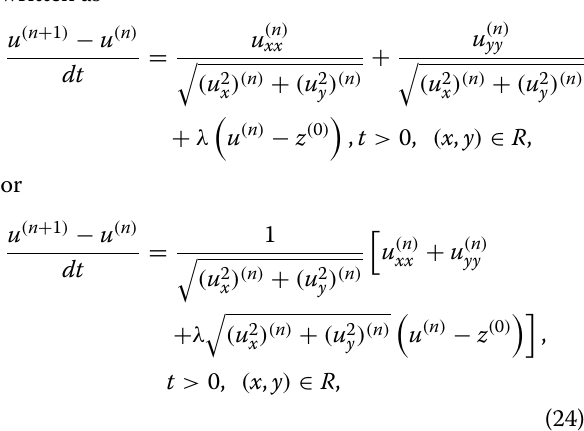
Algorithm 3 :Algorithm for proposed method M3